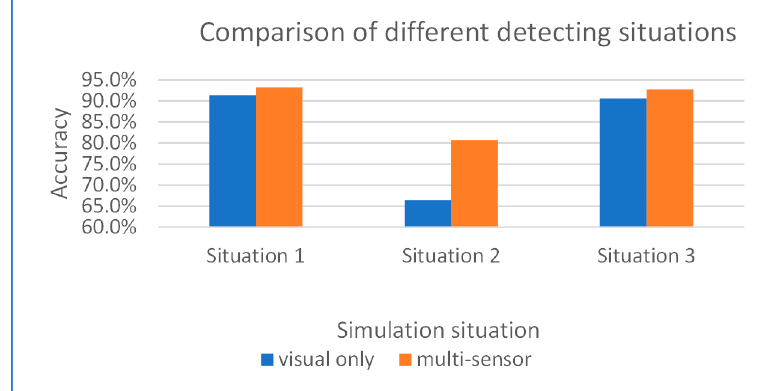
Figure 14. Comparison of different detection situations.